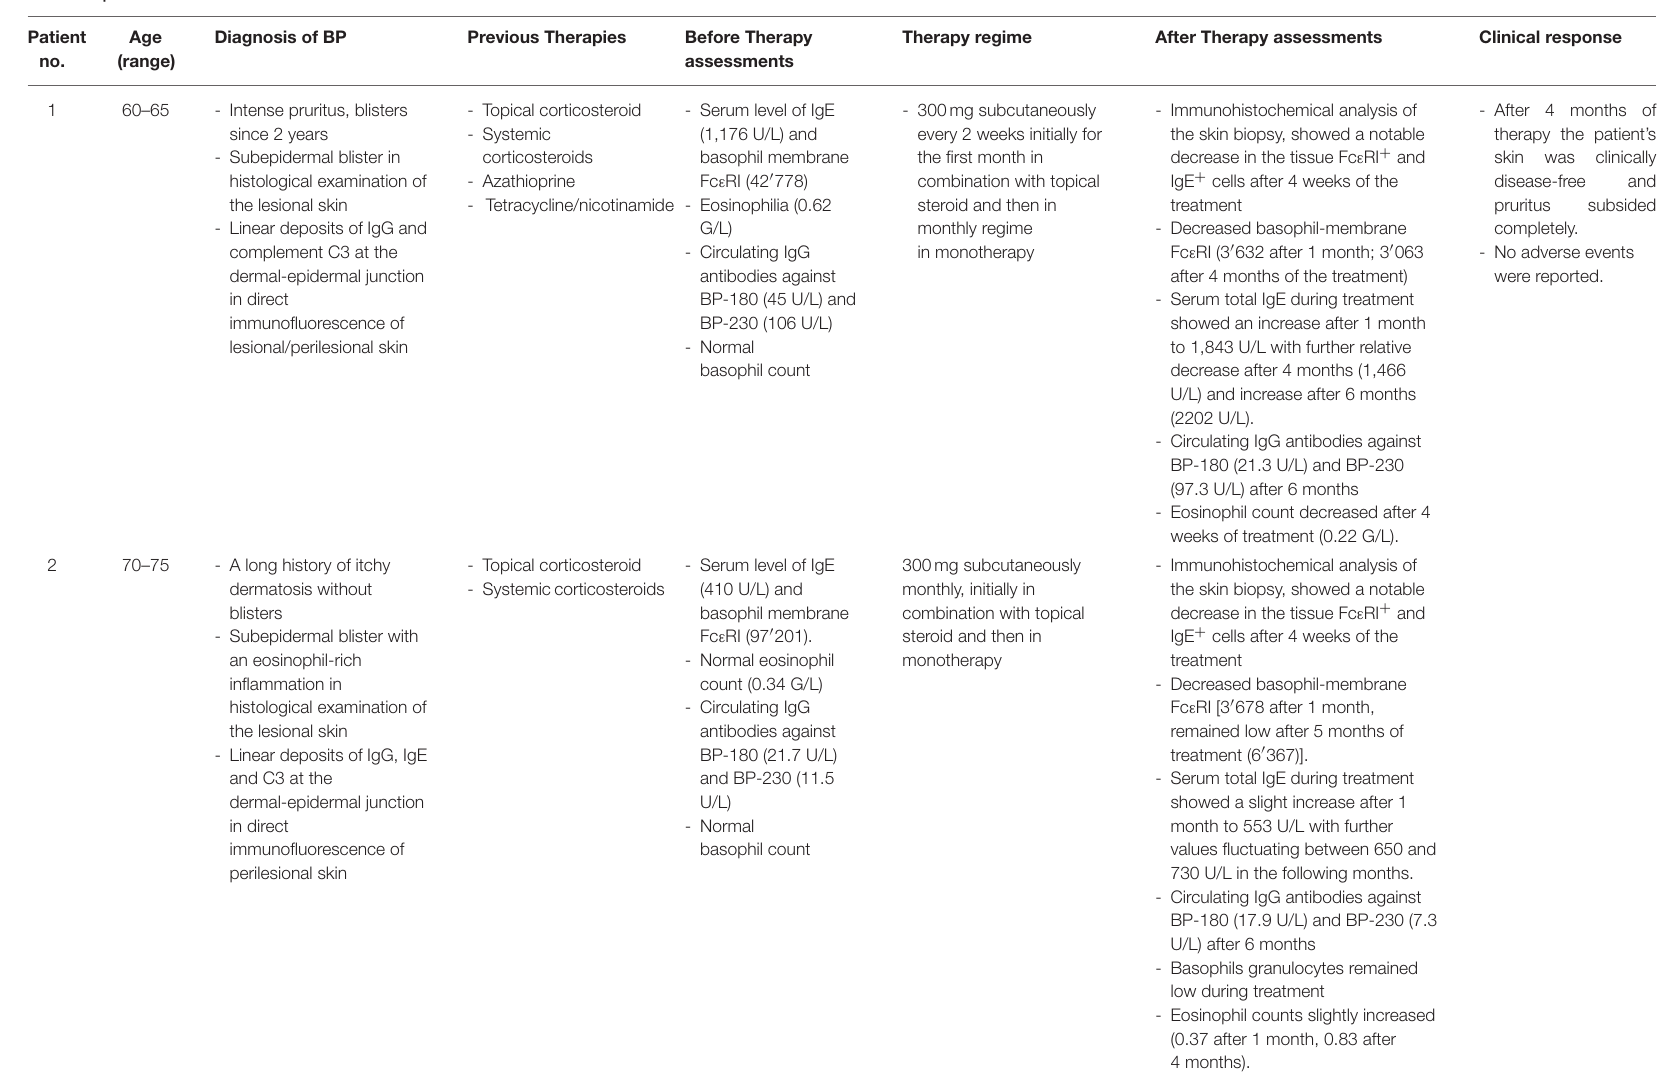
TABLE 1 | Patients characteristics. Patient